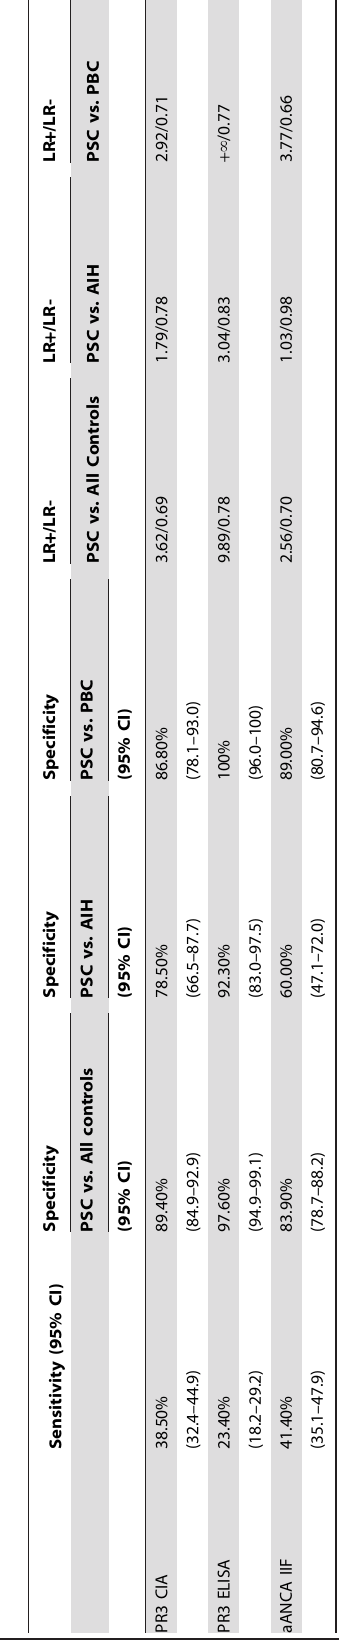
6.4 CU, AIH-PBC 3.7 CU, PBC 2.7 CU, HCV 2.1 CU, HBV 2.7 CU, healthy controls 4.4 CU (Figure 2). 40 41 . The available clinical and biochemical parameters of the PSC patients are reported in Table 3. PR3-ANCA positivity by CIA was associated with younger age (p , 0000.1), higher ALT (p = 0.0002), AST (p , 0.0001), ALP (p , 0.0001), and platelet levels (p= 0.0076). PR3-ANCA did not significantly distinguish between sex, disease duration, small duct PSC, cholangiocarci- T noma, cirrhosis, esophageal varices, ascites, hepatic encephalop-